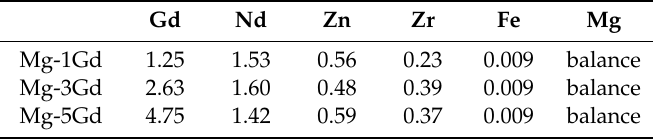
Table 1. Compositions of the as-cast Mg-xGd-Nd-Zn-Zr alloys (wt.%).